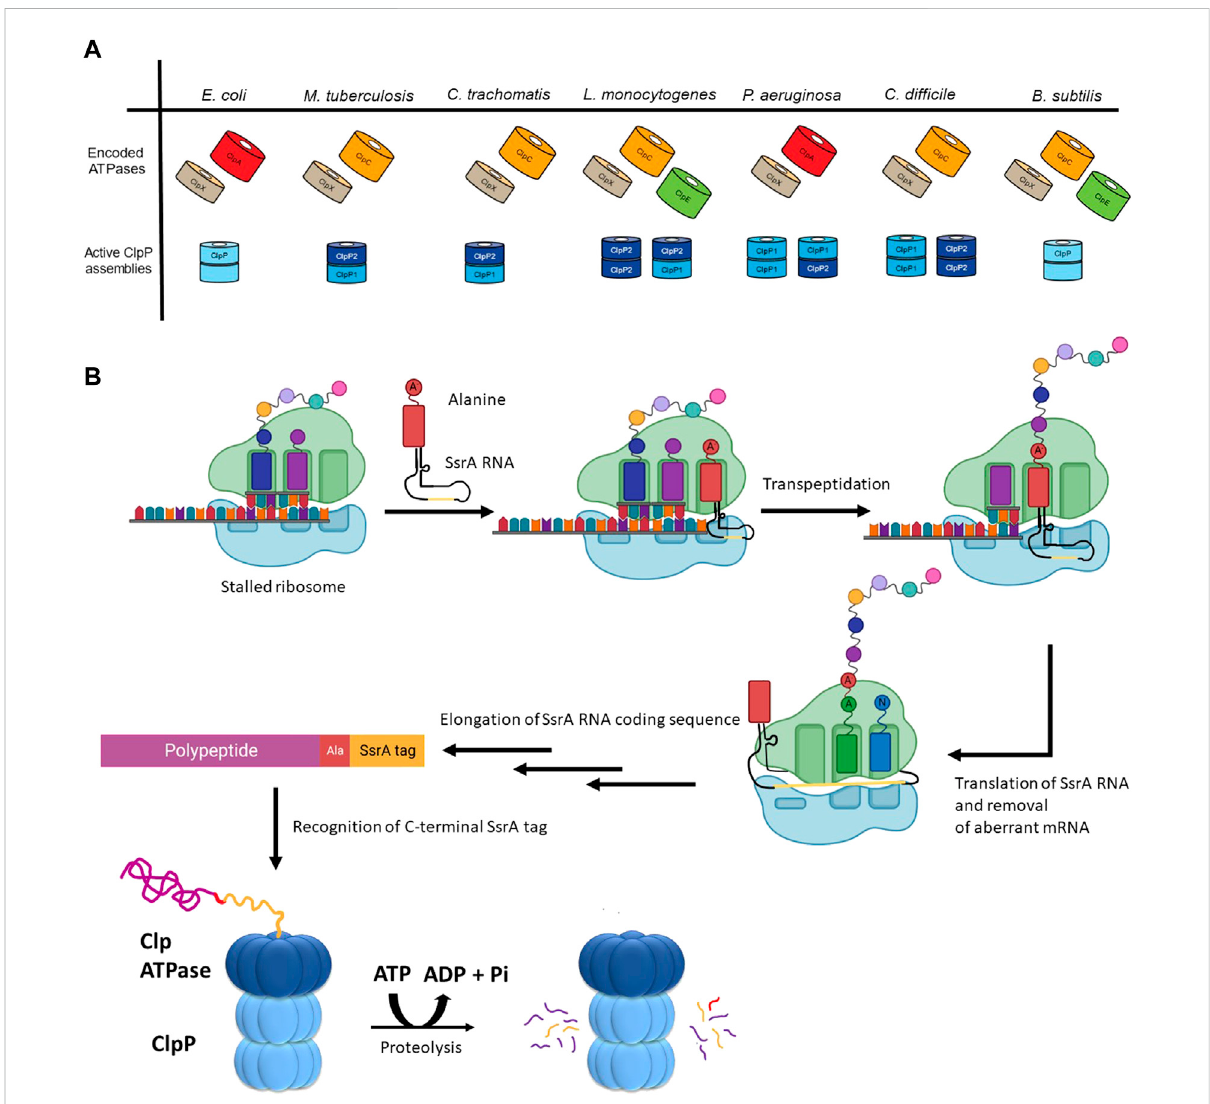
FIGURE 2 The diversity of ClpP substrate regulation. (A) The Clp ATPases and ClpPs of a select group of bacterial pathogens are shown. The tetradecameric organization for the active form(s) of the ClpP protease for each of these species is also shown. (B) Shown is the mechanism of SsrA tagging of nascent chains as means of targeting them for ClpP-mediated degradation. During translation of aberrant mRNAs lacking a stop codon, the ribosome stalls, resulting in the recruitment of a charged alanine-SsrA RNA (tmRNA) to the A site of the ribosome.